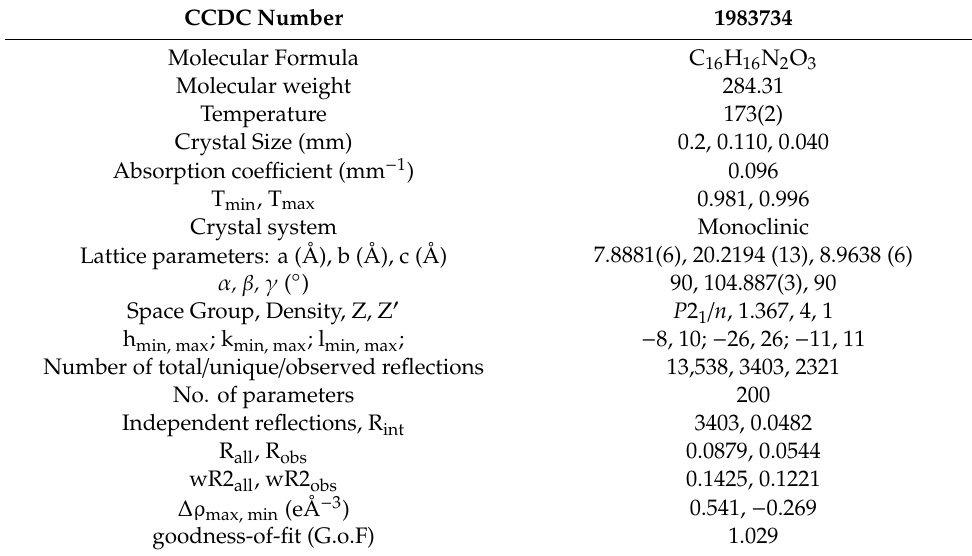
Table 2. Single-crystal X-ray data of title compound